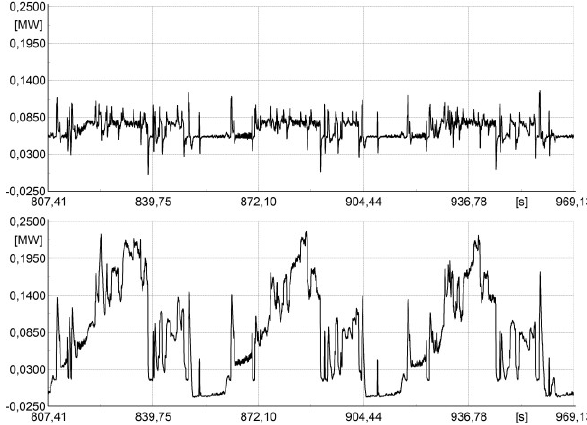
Figure 10. Calculation: transient process of the pontoon crane operation with ESS in the regime of limiting the deviations of the load from the mean value (from top to bottom - the power of the generator, the load power)